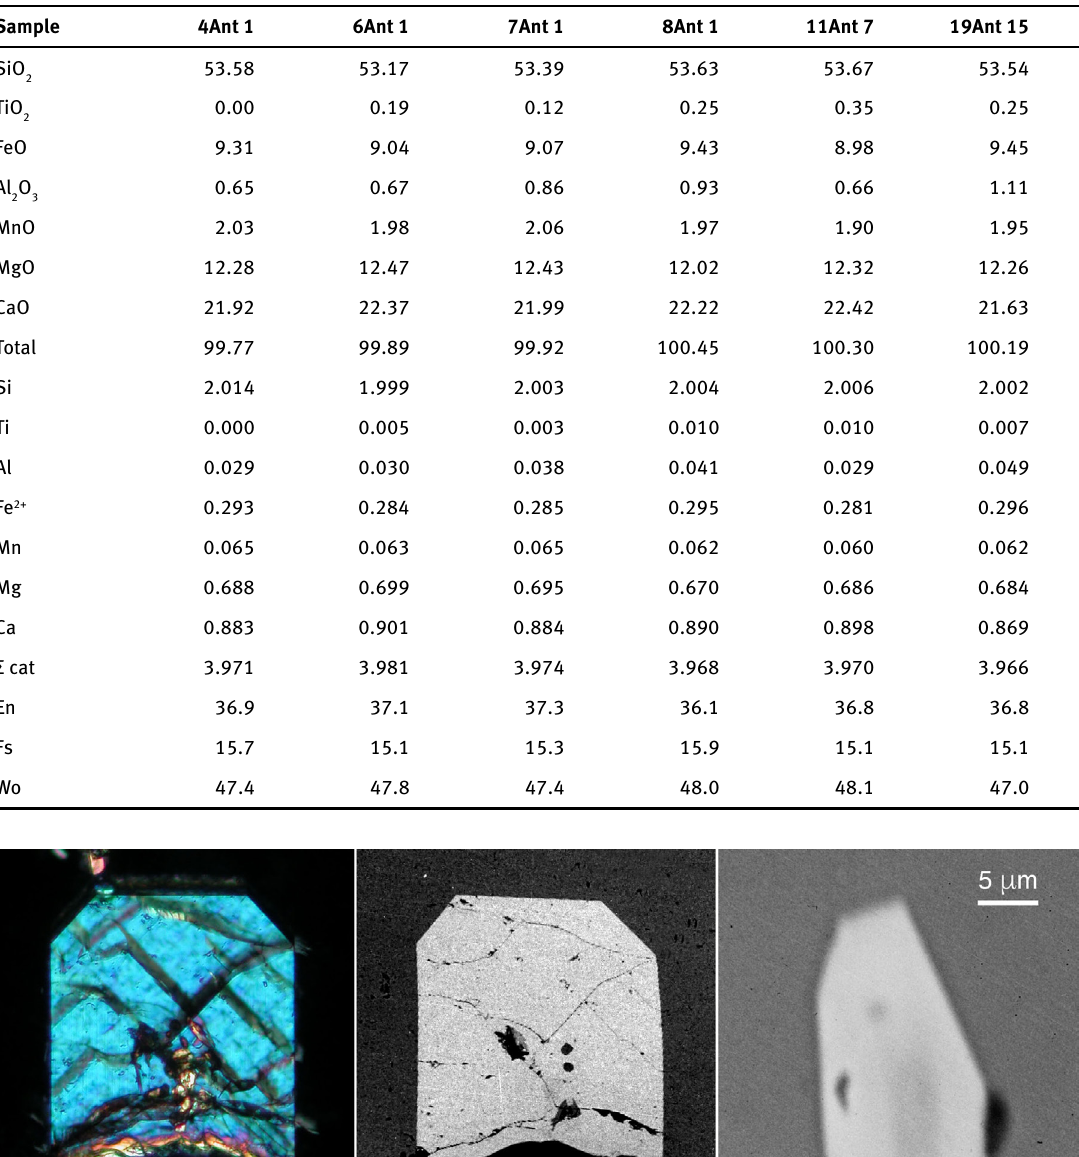
Table 2. Pyroxene microanalyses of the Antiparos obsidians; formula on the basis of 6 oxygens. En: enstatite, Fs: ferrosilite, Wo: wollastonite.